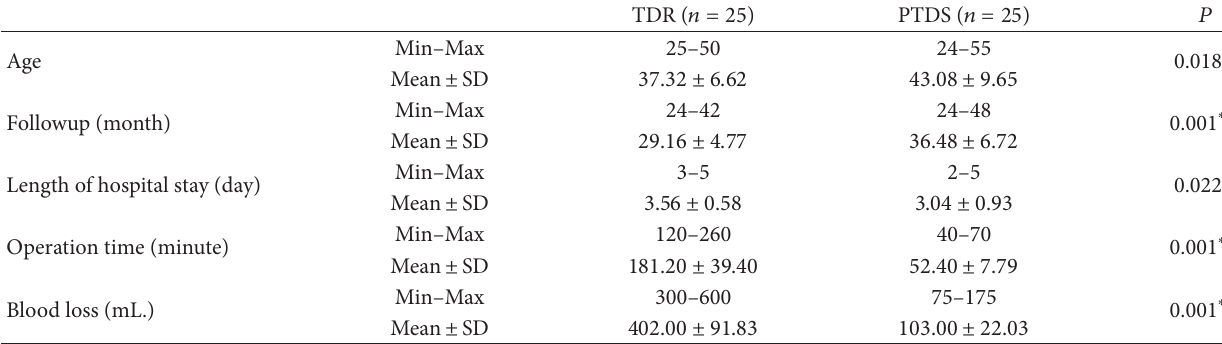
T 1: Comparison of TDR and PTDS